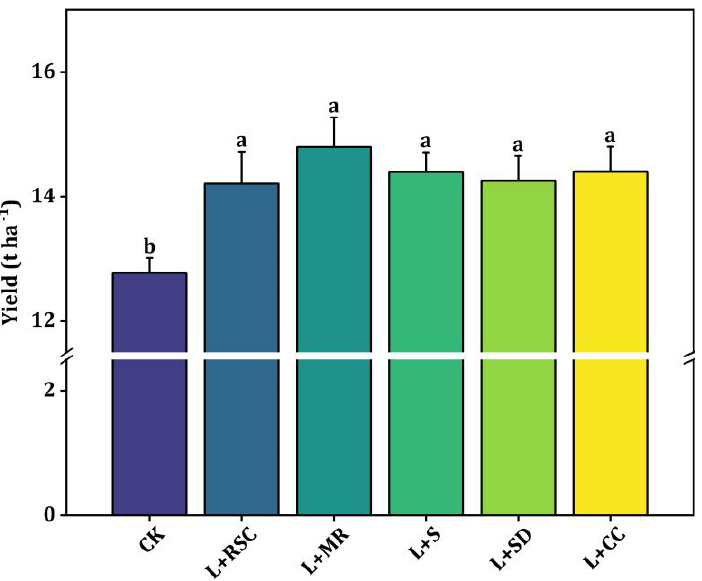
Figure 3. Effect of LOM on yield of A. selengensis . All values are means of three replicates with error bars indicating the standard error. Different lowercase letters show significant variability among treatments ( p <